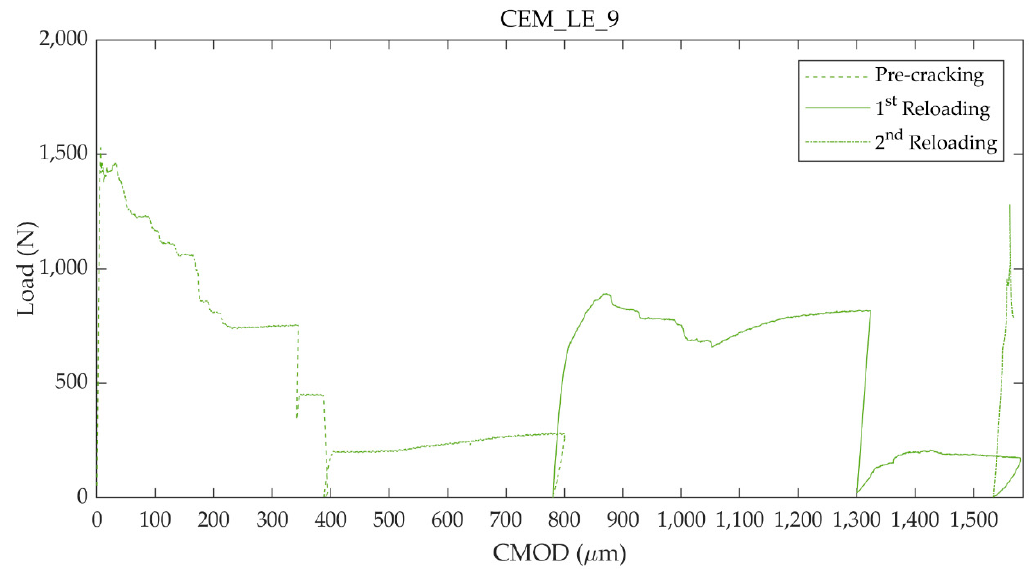
Figure 11. Load versus CMOD curves for the specimen CEM_LE_9 during the pre-cracking (CMOD up to 800 µm), the first static reloading in which there was a drop in load followed by a new PU release and the subsequent second static reloading after PU curing.